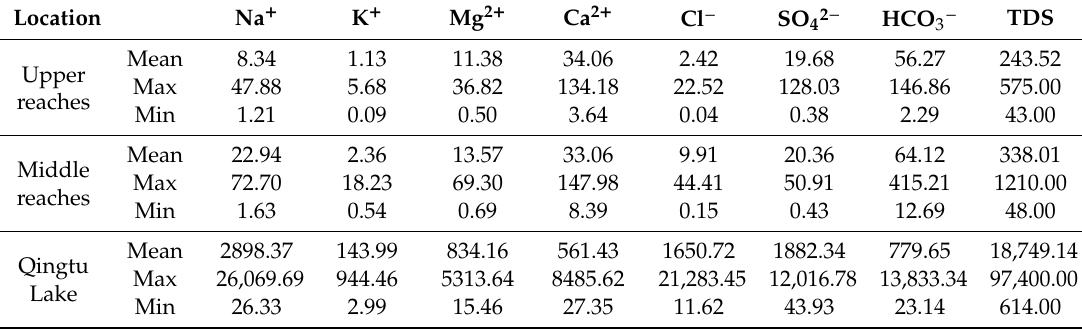
Table 4. Descriptive statistics of ion concentration in Qingtu Lake and upper-middle reaches of the Shiyang River Basin (Unit: mg L − 1